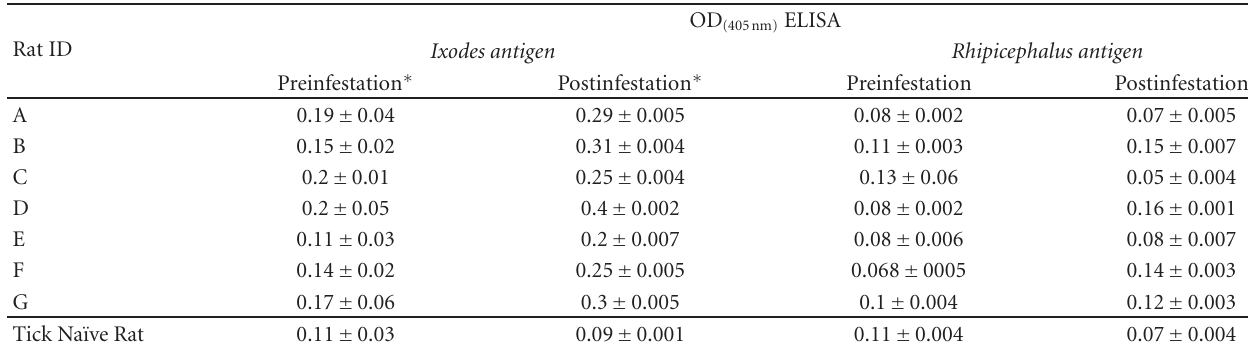
Table 2: The reaction of sera from rats exposed to Ixodes holocyclus ticks with Ixodes holocyclus and Rhipicephalus ( Boophilus ) microplus antigens in